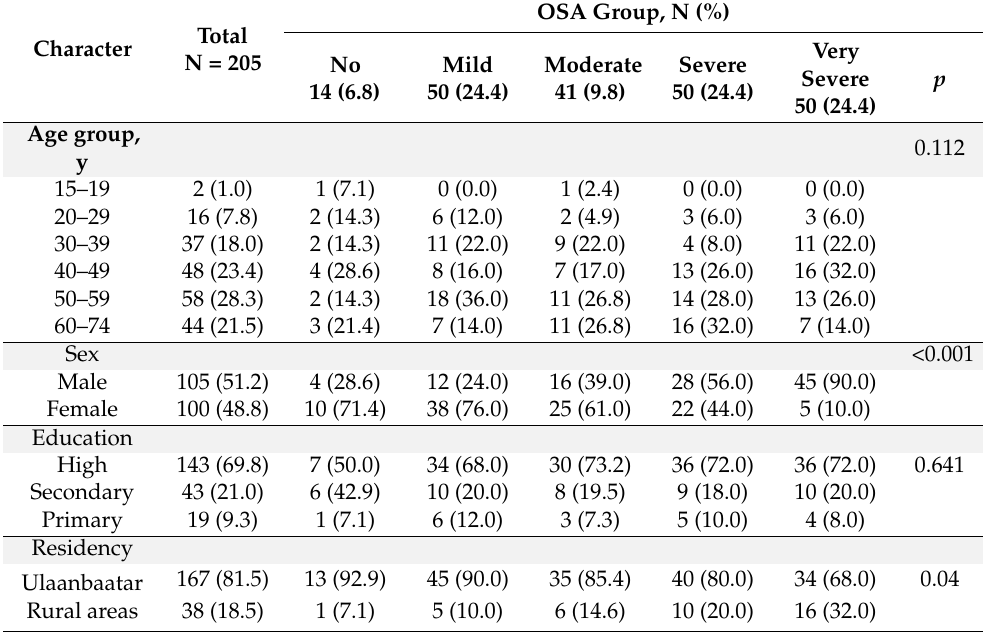
Table 1. Demographic characteristics of patients in sample and across OSA